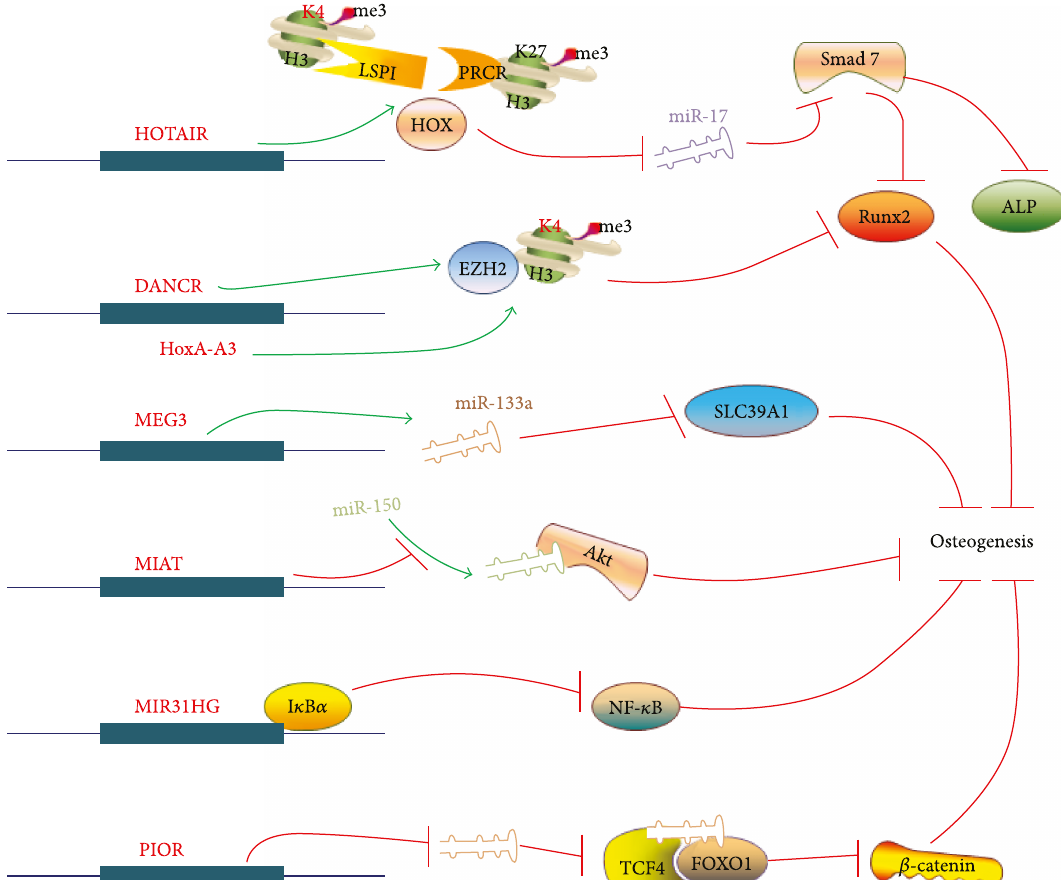
Figure 3: lncRNAs that contribute to lineage-speci fi c phenotypes of